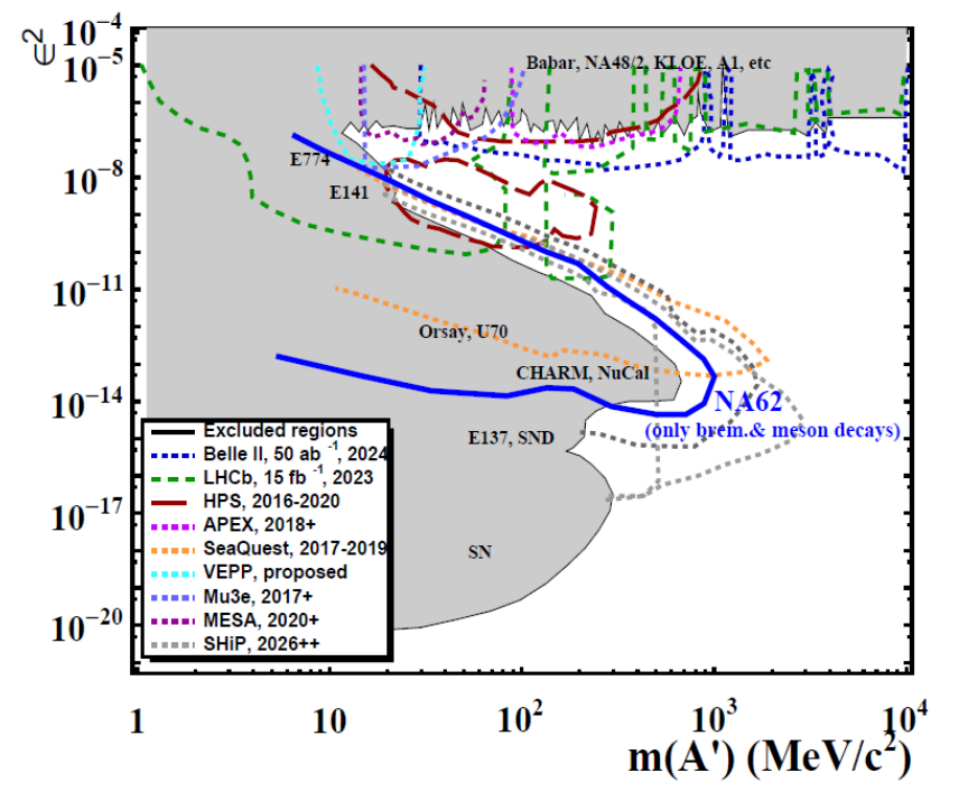
Figure 7. NA62 projected sensitivity (at 90% CL) in the plane DP-photon coupling ( (cid:101) ) vs. DP mass for DP to visible decays